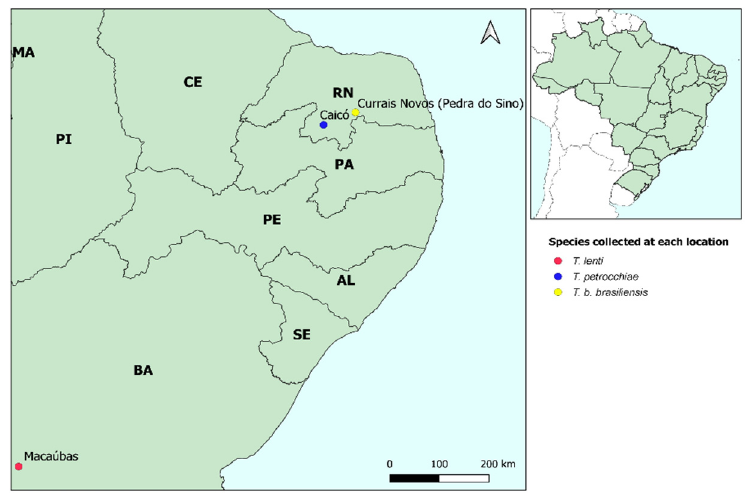
Figure 1. Distribution map of species used in experimental crosses.